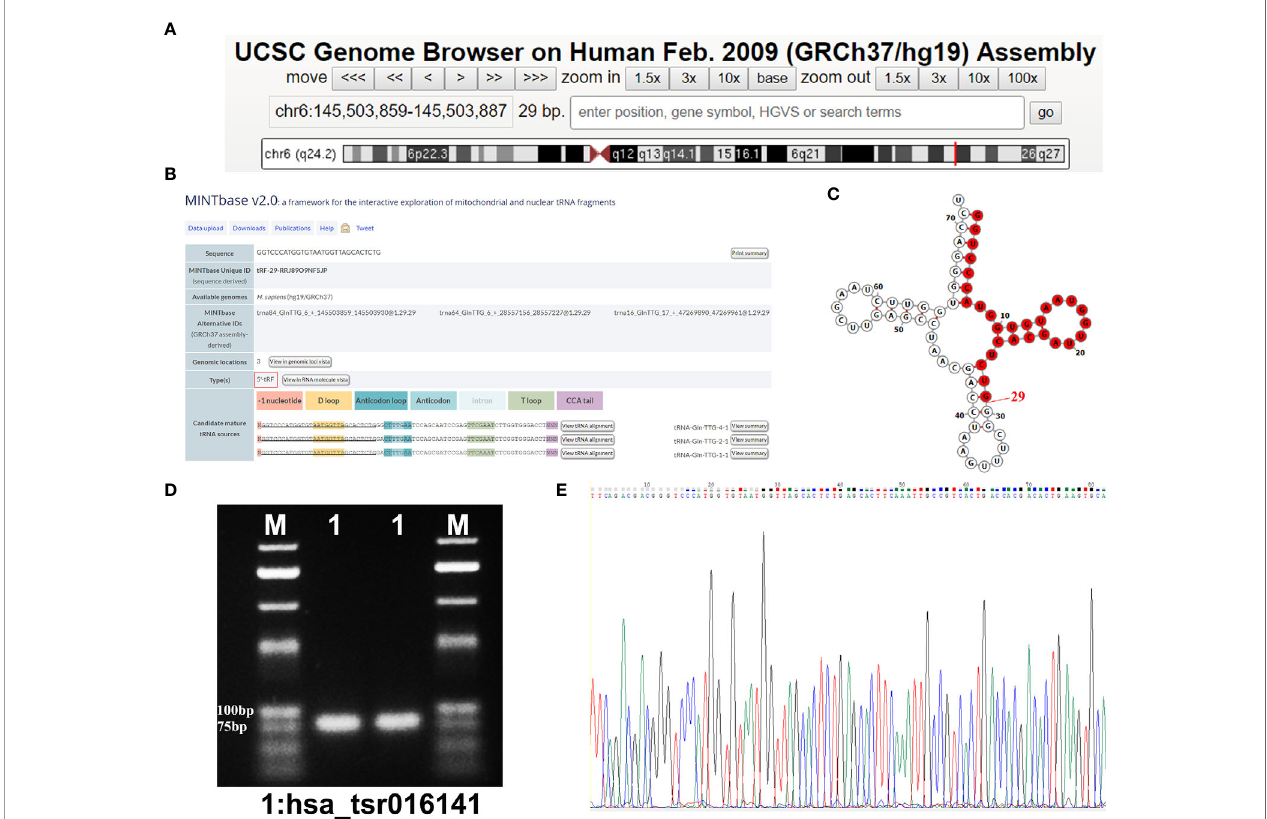
FIGURE 2 | Hsa_tsr016141 isa kindoftRFs. (A) hsa_tsr016141 was mappedto chromosome 6q24.2 with coordinates of 145,503,859 – 145,503,887. (B) hsa_tsr016141 was a 5 ’ tRF of tRNA-Gln-TTG,which was processed fromtRNA-Gln-TTG-1-1, tRNA-Gln-TTG-2-1, and tRNA-Gln-TTG-4-1. (C) TakingtRNA-Gln-TTG-4-1 as an example, the cleavage site of hsa_tsr016141 was located above the anticodon loop. (D) The product of qRT-PCR was run on 2% agarose gel, showing a single electrophoresis band. (E) The product of qRT-PCR was con fi rmedby Sanger sequencing that contained the full-length sequence of